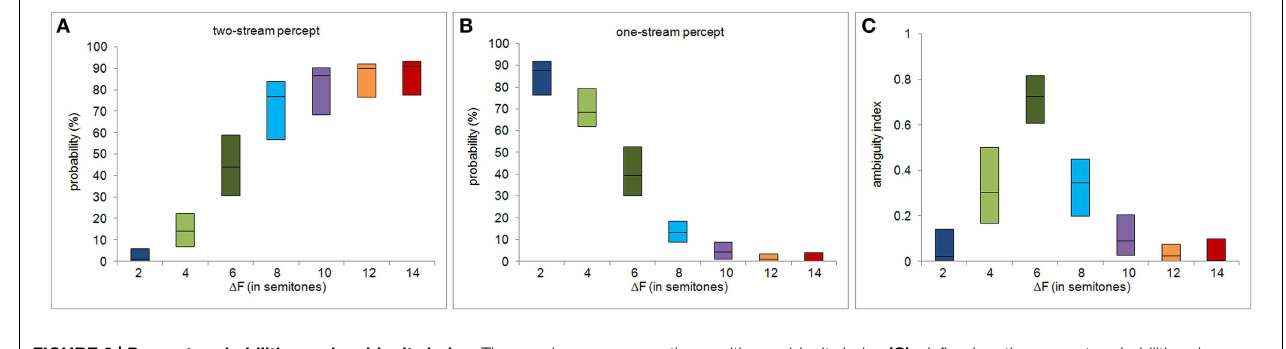
FIGURE 2 | Percept probabilities and ambiguity index. The panels show, as functions of 1 F, the proportions of time that the stimulus sequences were perceived as two streams (A) and as one stream (B) , and